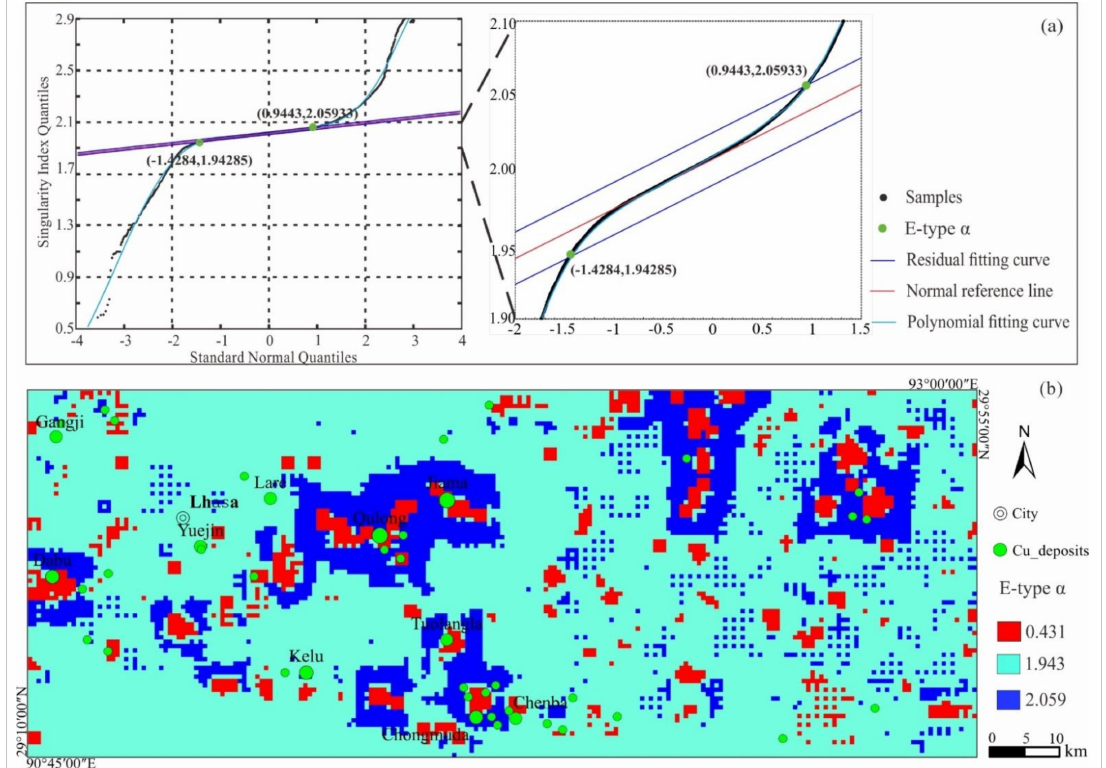
Figure 11. E-type α map by means of S-Q method in ( a ) frequency domain and ( b ) spatial